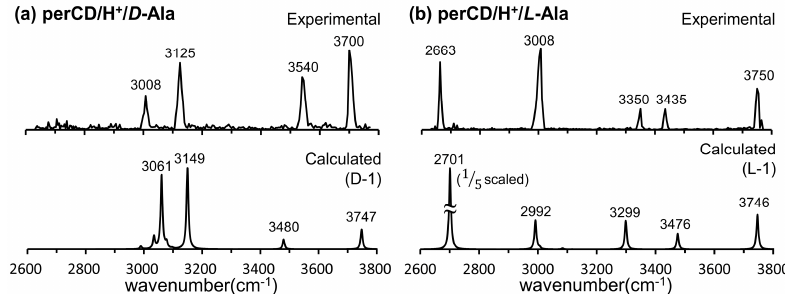
Figure 13. Experimental IRMPD and calculated IR spectra of the per- β -CD/H + / D -Ala and / L -Ala complexes. Reproduced from Reference [59] by permission of the PCCP Owner Societies.